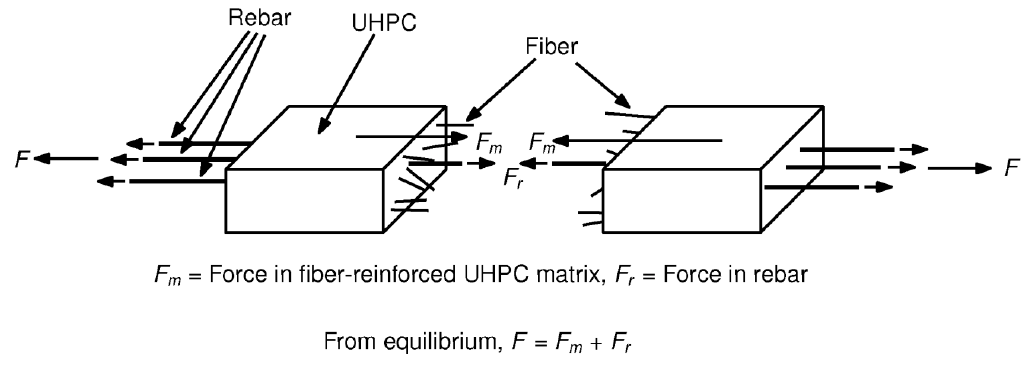
Figure 3. Reinforced UHPC during softening (idealized).